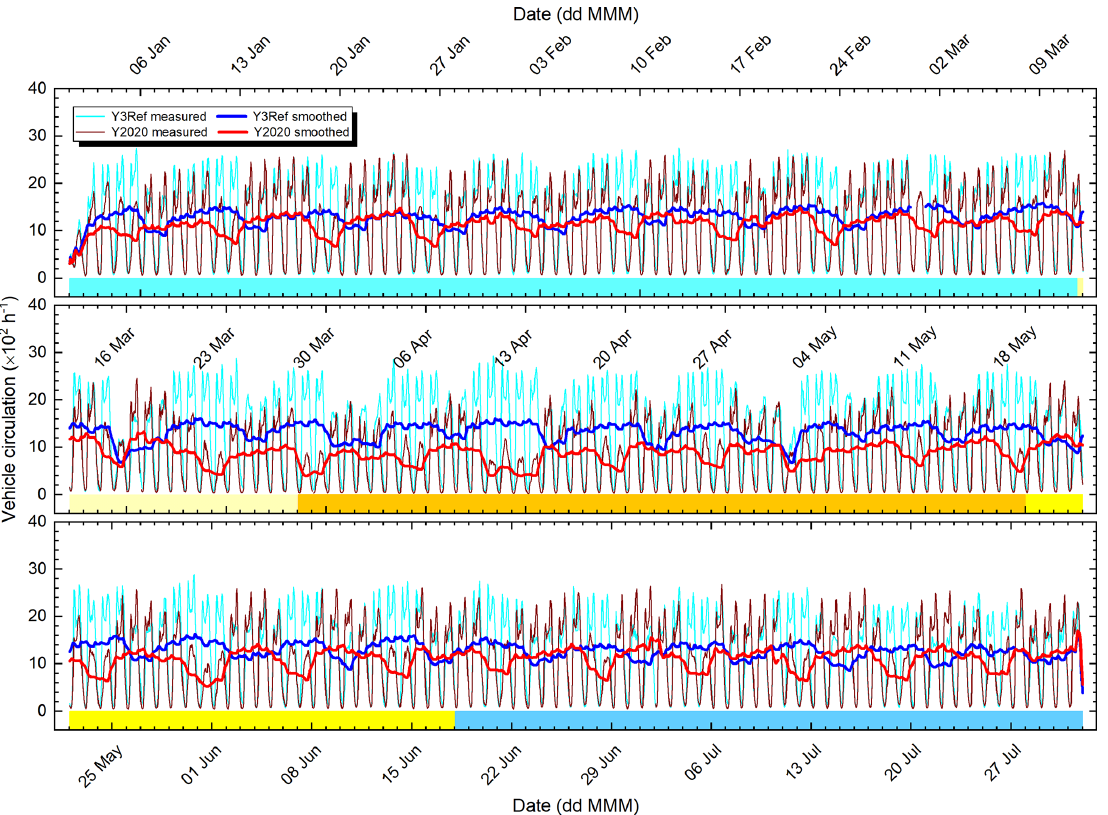
Figure 2. Time series of motor vehicle circulation on a major route (Váci Road) in Budapest in both directions in the average reference year comprising 2017–2019 (Y3Ref) and year 2020 together with their 24h smoothed curves over the five consecutive phases of the first COVID-19 outbreak. The phases are marked by the following colour codes: Pre-emergency phase lighter blue, Pre-restriction phase lighter yellow, Restriction phase orange, Post-restriction phase darker yellow and Post-emergency phase darker blue. The tick labels of the abscissa indicate the Mondays in